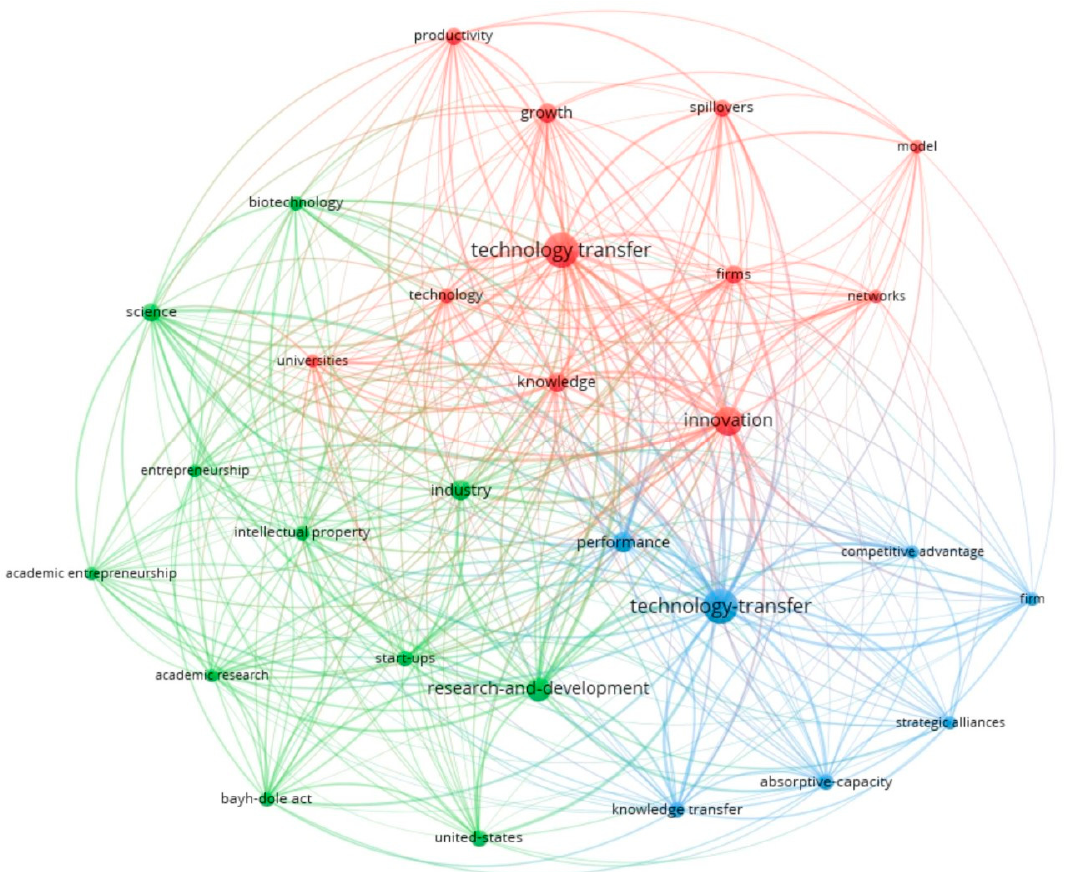
Figure 1. Main streams of research regarding technology transfer at universities.